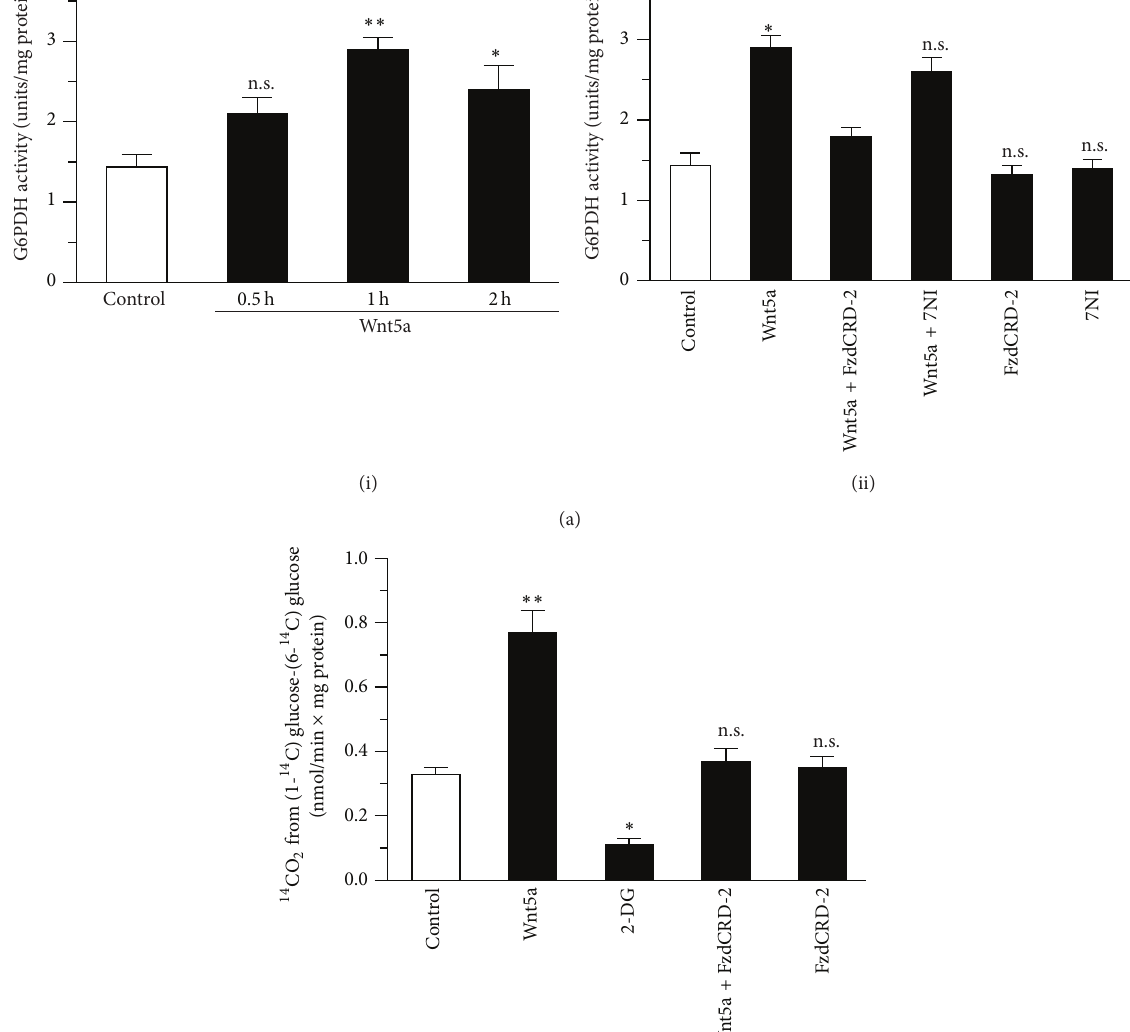
in mitochondria through oxidative phosphorylation. By